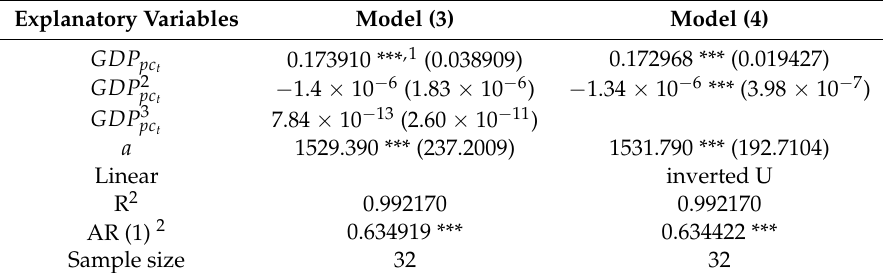
Table 3. Comparison of Models (3) and (4).